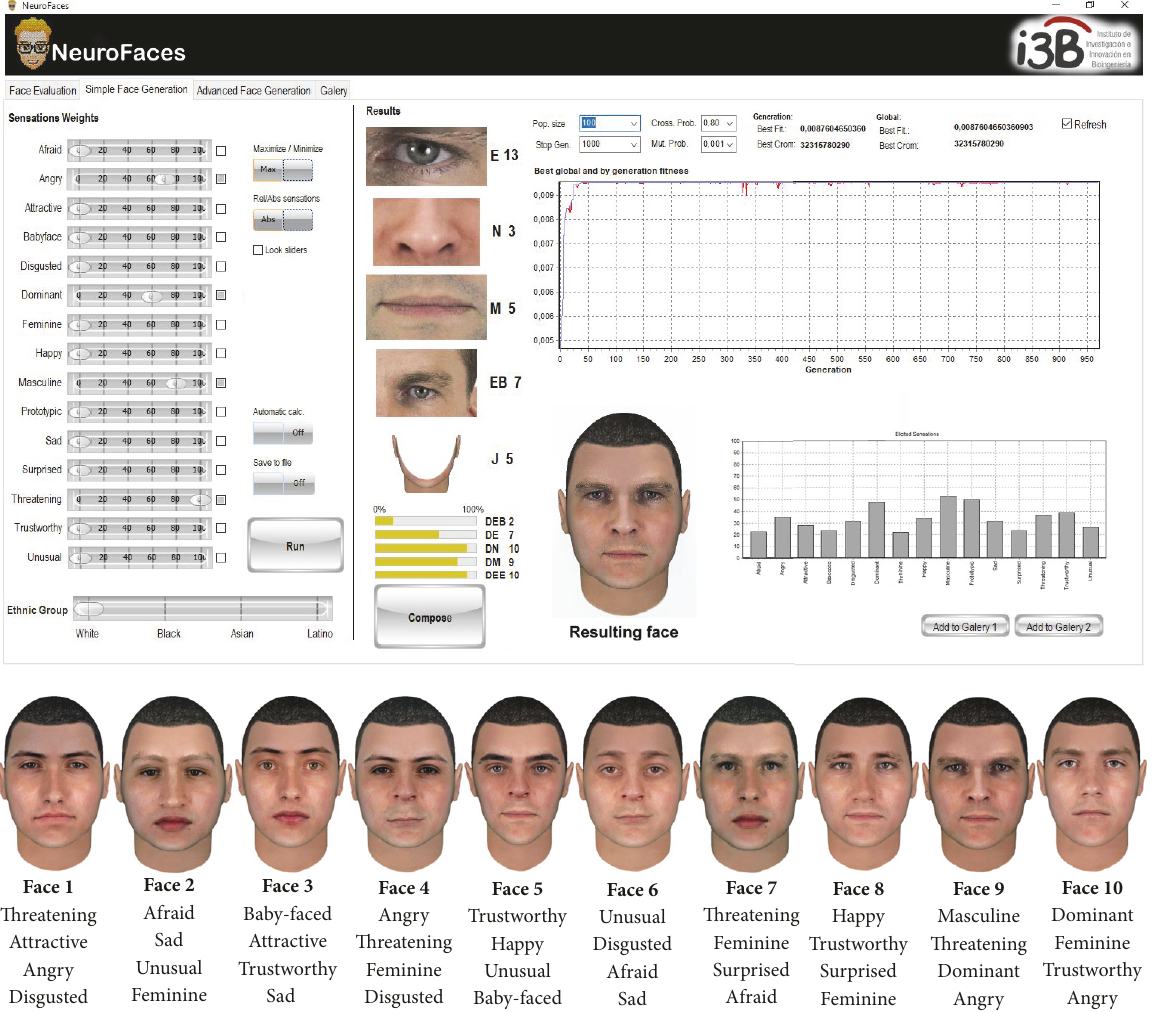
Figure 8: Software implementing the genetic algorithm and the Poisson Image Editing method, and 10 faces generated using the software.